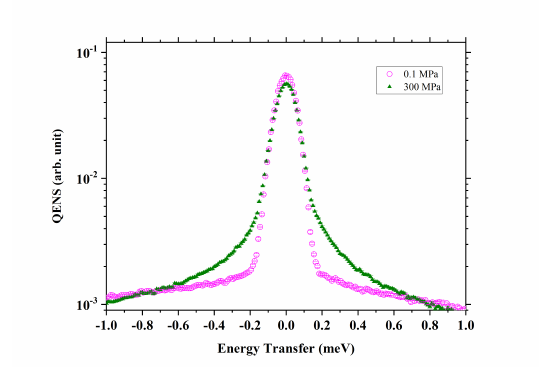
Fig. 7. QENS indicates the phase transition from the α - phase to β -phase upon applying 300 MPa pressure for NH I. 4